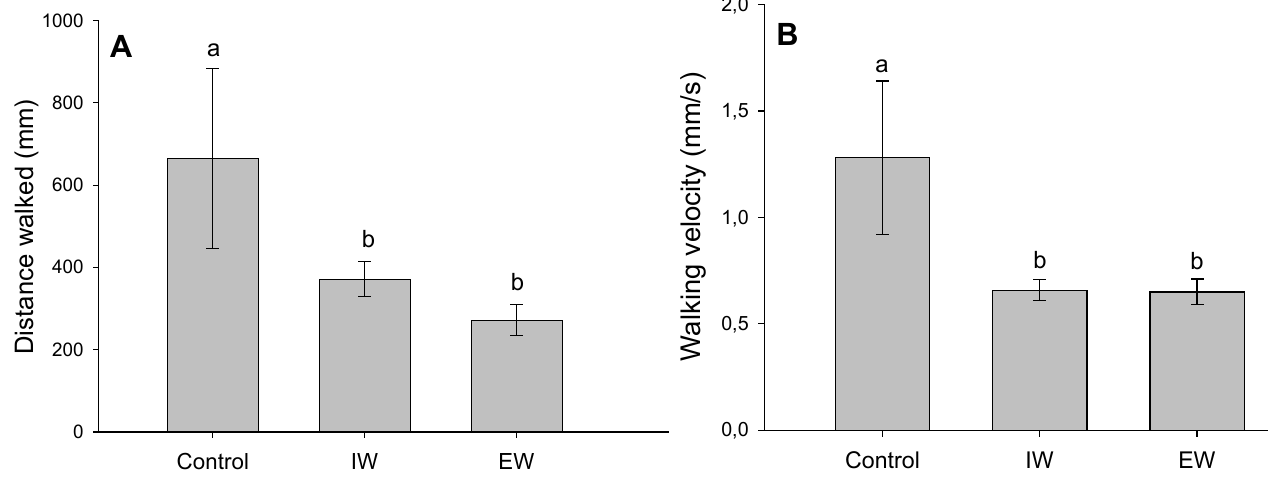
Fig 3. Distance walked (A) and walking velocity (B) of Inquilinitermes microcerus workers in the following treatments: control (inquiline workers alone), IW (inquiline workers in contact with substrate from the inner wall of host nest) and EW (inquiline workers in contact with substrate from the external wall of host nest. Different letters in each graphic indicates significant difference among